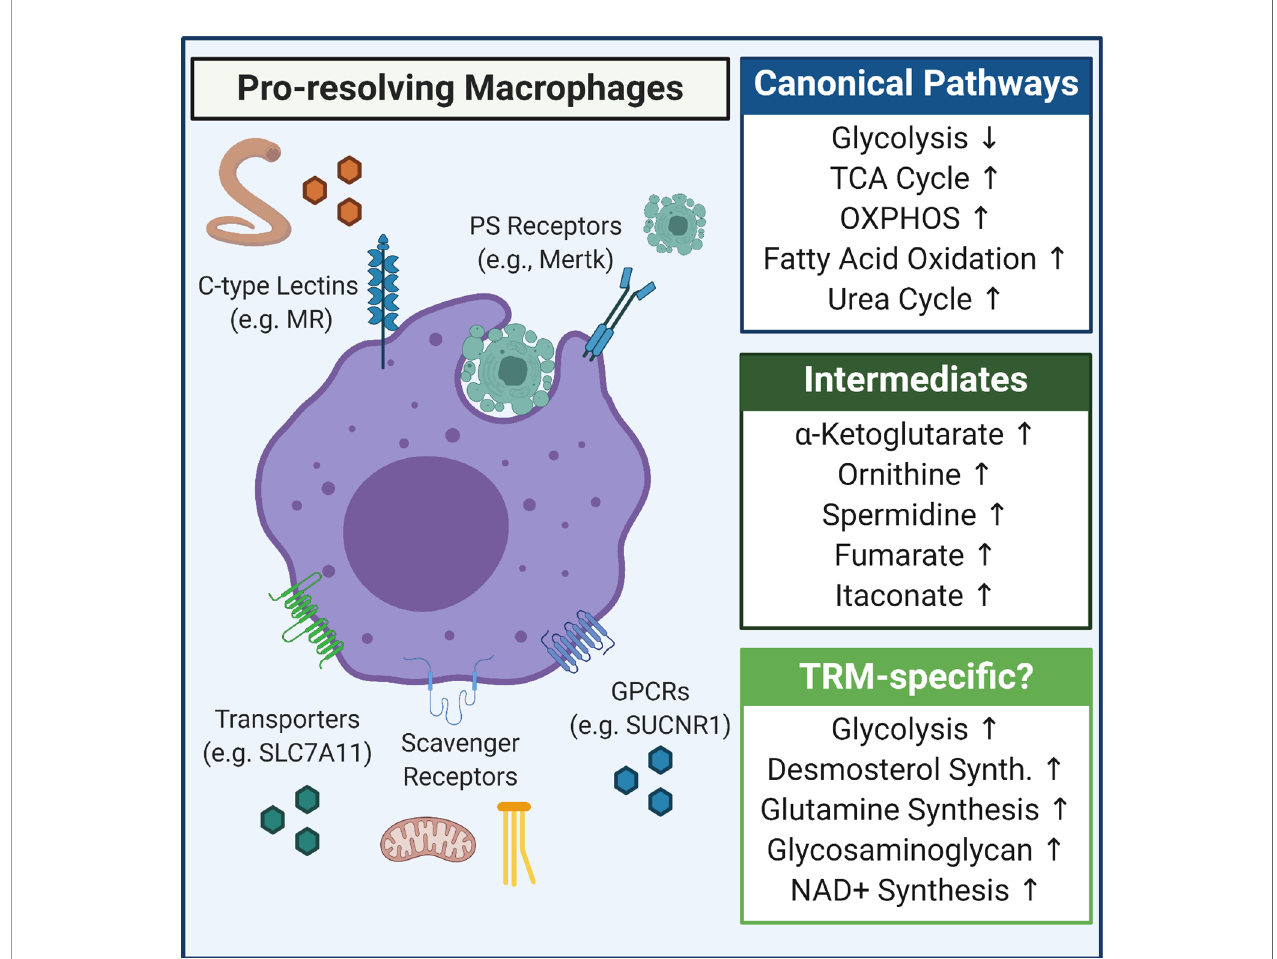
FIGURE 2 | Overview of metabolic pathways induced in pro-resolving macrophages. Shown is the canonical anti-in fl ammatory/pro-resolving macrophage metabolic program (Canonical Pathways) as well as some of the more predominantly de fi ned intermediates that accumulate in pro-resolving macrophages (Intermediates). Also included are some tissue-resident macrophage (TRM)-speci fi c metabolism observations, including that apoptotic cells and/or cytokine (e.g., IL-4/IL-13) induce upregulation of glycolysis, that succinate accumulates and signals via SUCNR1 to drive in fl ammation resolution, and that novel pathways such as desmosterol synthesis are induced in speci fi c tissues, such as the